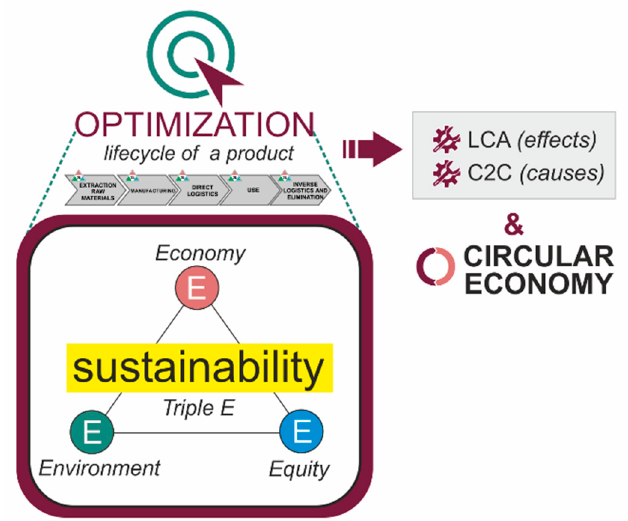
Figure 1. Sustainability, Triple Bottom Line and Optimization. LCA/C2C/Circular Economy.